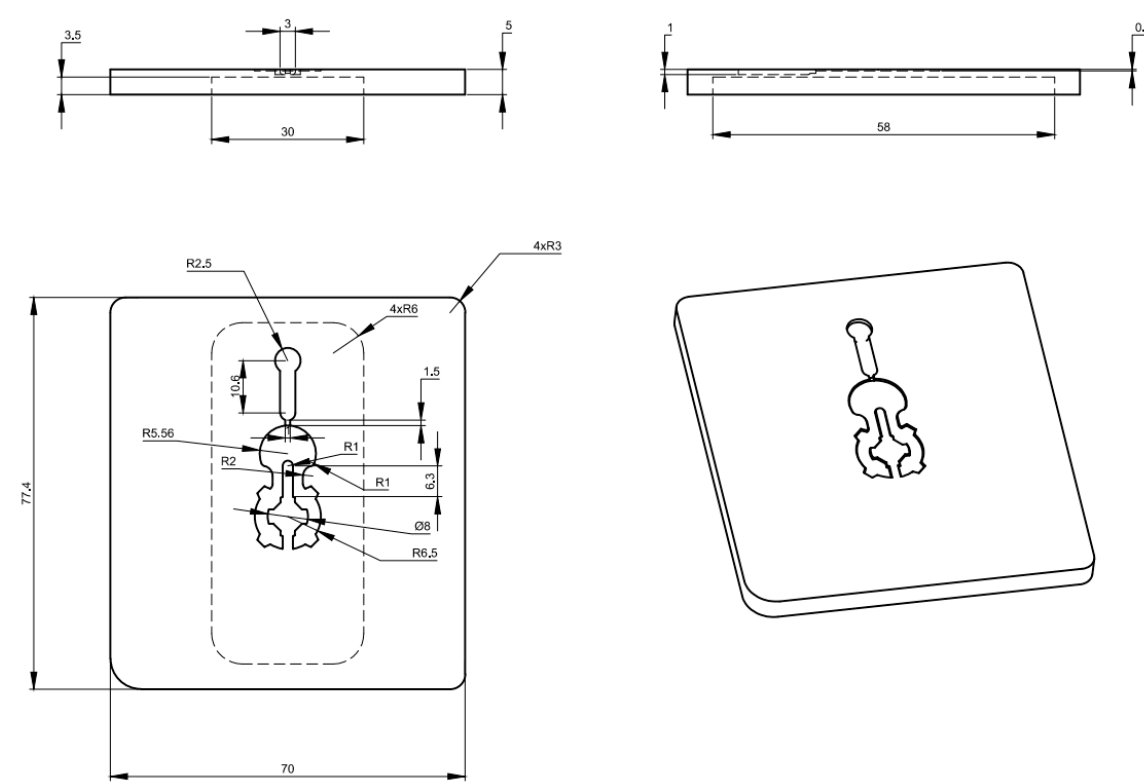
Figure 5. Cavity dimensions.